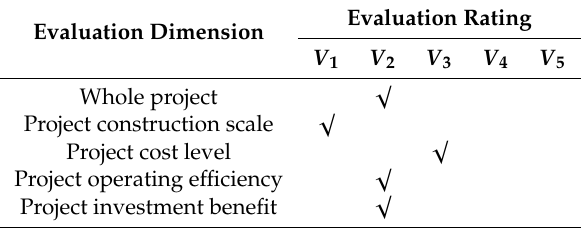
Table 9. The evaluation rating of each evaluation dimension (Project